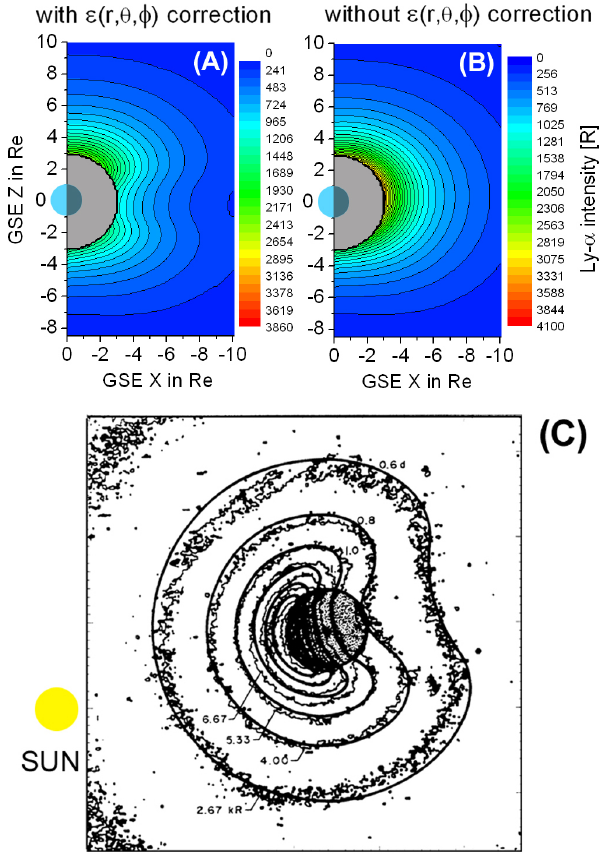
Figure 2. Calculated and photographed Lyman- α column bright- nesses of the terrestrial exosphere. The image in (a) (in units of [R])) was calculated above 3 R e taking into account the change in the lo- cal Lyman- α illumination caused by geocoronal multiple-scattering effects. The image in (b) is similar to (a) but without the multiple- scattering correction. Image (c) shows the Lyman- α column bright- ness in [kR] as photographed by Apollo 16 from the Moon (taken from Carruthers et al., 1976). The observed shape of the emission as seen from the Moon is in qualitative agreement with the calculated shape in image (a)